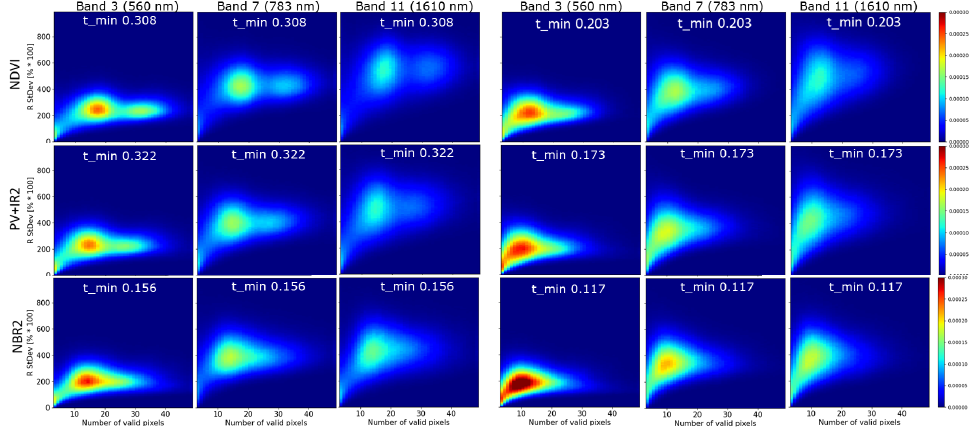
Figure 11. Histogram plots for the generated SRC version showing the distribution of the SRC standard deviation s to the number of valid pixels for selective S2 bands (centre wavelength of the S2 bands are given in brackets according to